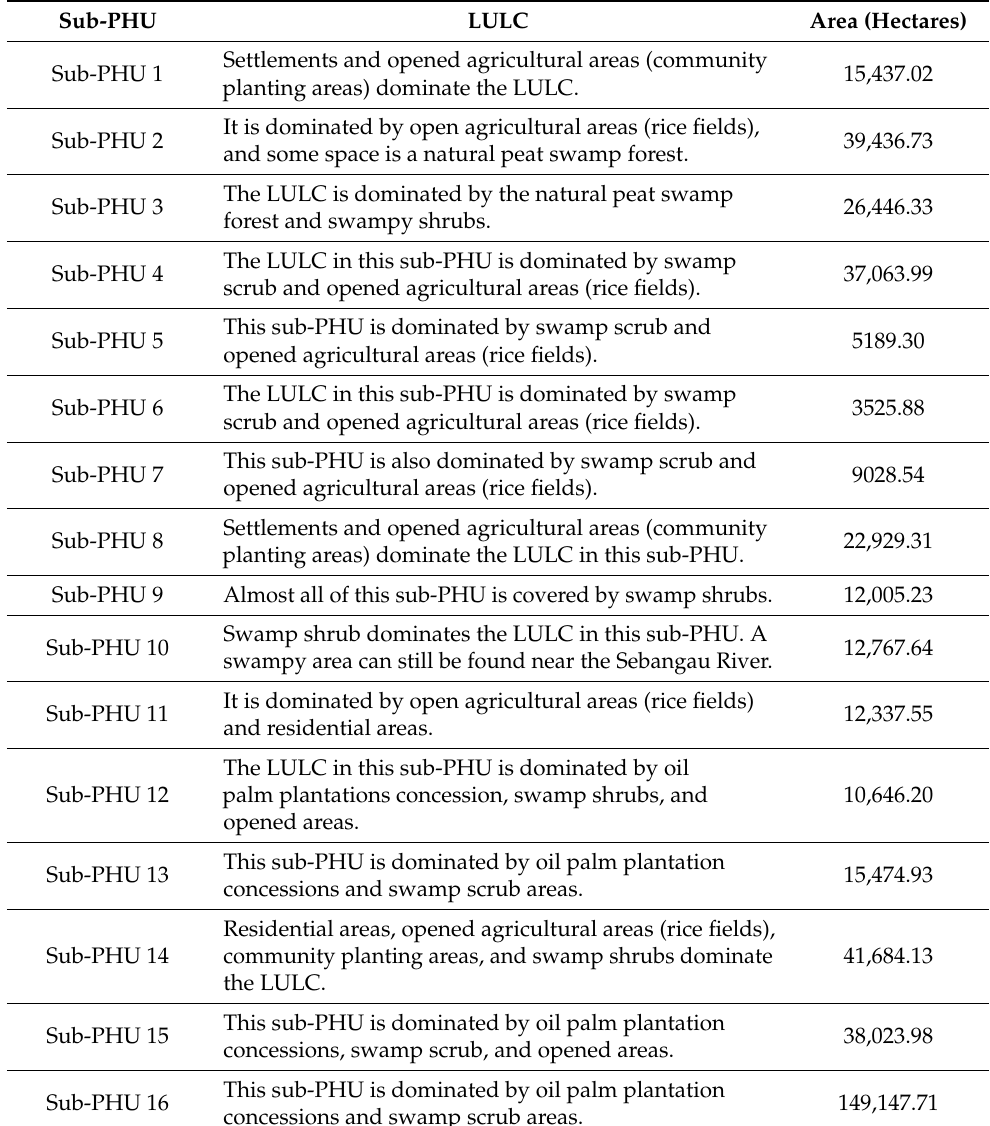
Table 1. Description of the LULC for each sub-PHU in Kahayan–Sebangau